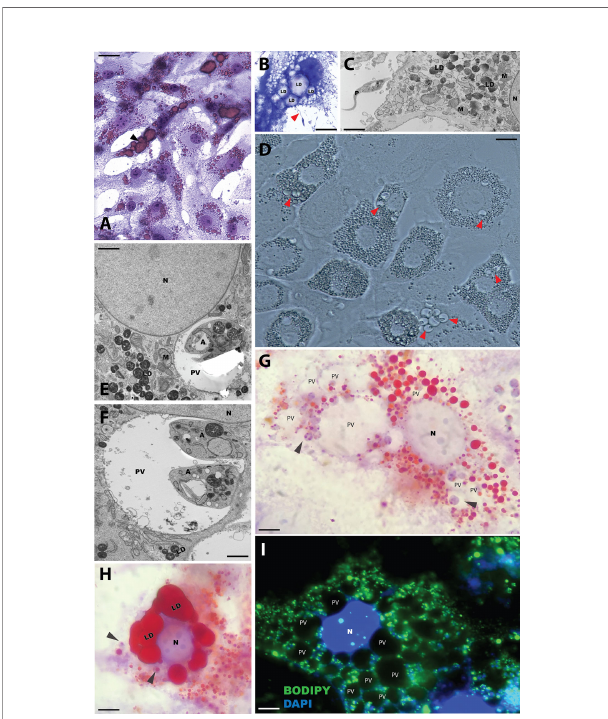
FIGURE 1 | Representative micrographs of 3T3-Ad in vitro infected with L. (L.) amazonensis . (A) 3T3-L1 fi broblasts undergoing adipocyte differentiation after 14 days, in which lipid droplets are stained with Oil-Red O (arrowhead) and are observed in differentiated adipocytes stained simultaneously with Giemsa. Scale bar = 8 µm. (B) Differentiated adipocyte stained with Giemsa, in which hyaline lipid droplets (LD) spaces can be seen, were incubated with L. (L.) amazonensis stationary phase promastigotes (MOI=20) for 1 h. Note the promastigote attached to the adipocyte by the fl agellum (red arrowhead). Scale bar = 12 µm. (C) Ultrastructure showed a promastigote ( “ P ” ) close to the plasma membrane of an 3T3-Ad. “ M ” : mitochondria, “ LD ” : electron-opaque lipid droplets after osmium-imidazole treatment, “ N ” : nucleus. Scale bar = 5 µm. (D) Unstained infected 3T3-Ad as described in (B) , observed by phase contrast microscopy after 48 h. Red arrows point to PVs containing amastigotes. Scale bar = 6 µm. (E, F) Ultrastructure of PV with amastigotes (A) infected for 48h “ M ” : mitochondria, “ LD ” : electron-opaque lipid droplets after osmium-imidazole treatment, “ N ” : nucleus. Scale bar = 0.5 µm. Representative 3T3-L1 pre- adipocyte (G) and 3T3-Ad (H) infected for 48 h and stained with Giemsa and Oil-Red O, where small red droplets (LD) are dispersed throughout the cytosol close to PVs harboring amastigotes (arrowheads) (G) . Bulky droplets (LD) stained in red (H) , with amastigotes nearby (arrowheads). “ N ” : nucleus. Scale bars (G) = 2.5 µm; (H) = 3.5 µm. (I) Fluorescence microscopy of infected 3T3- Ad for 48 h. Lipid droplets stained with BODIPY 493/503 (green) are closely seen with PV. “ N ” : nucleus of host cell and parasites stained in blue with DAPI. Scale bar = 6